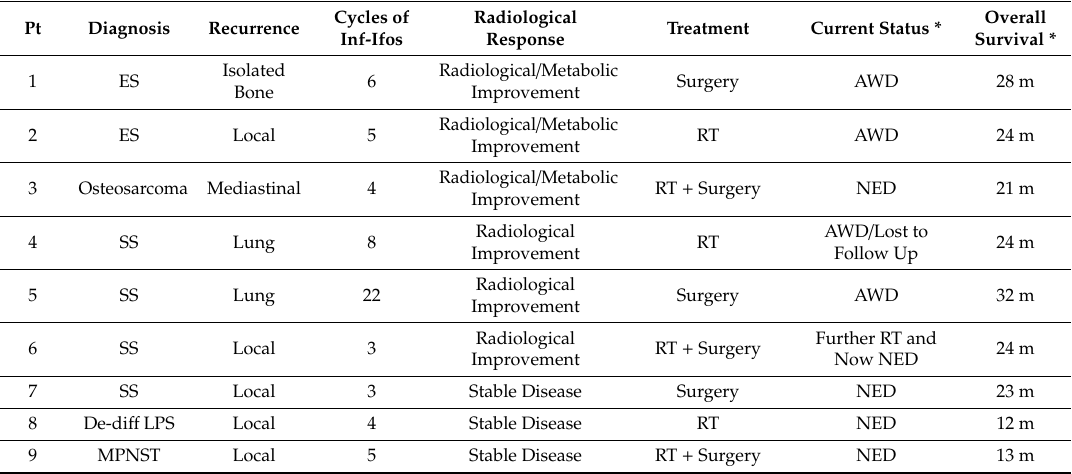
Table 2. Summary of patients who underwent consolidation treatment following treatment with infusional ifosfamide (Inf-Ifos).